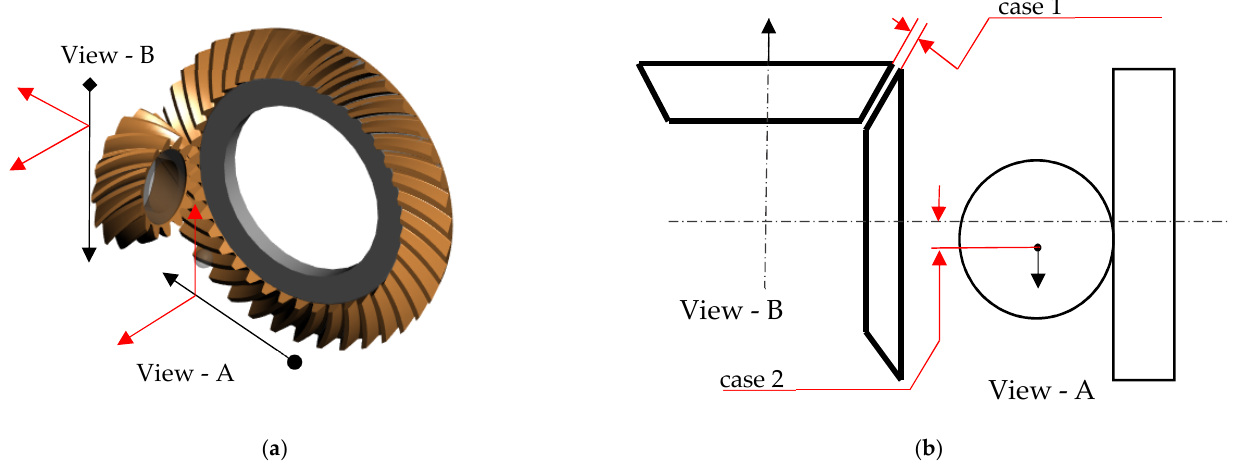
Figure 1. Geometric definition of misalignment errors; case 3 is the combination of the cases 1 and 2. ( a ) 3-D view of the SBG model. ( b ) 2-D view of the model to show the radial and axial misalignments. The dynamic equations of motion of this system (Figure 2) are given by [20–25]: